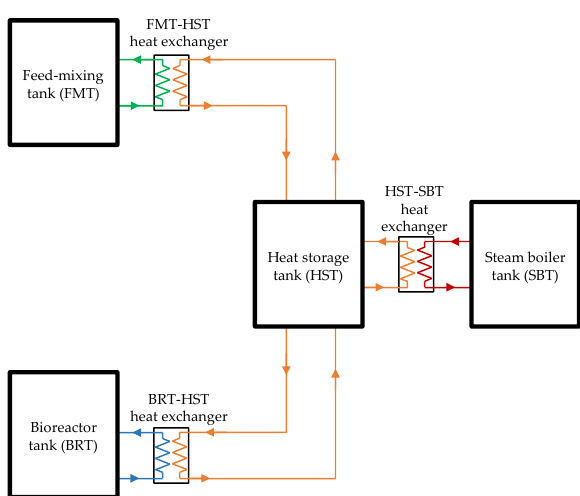
Figure 3. Schematic drawing of the lab-scale biohydrogen production system.